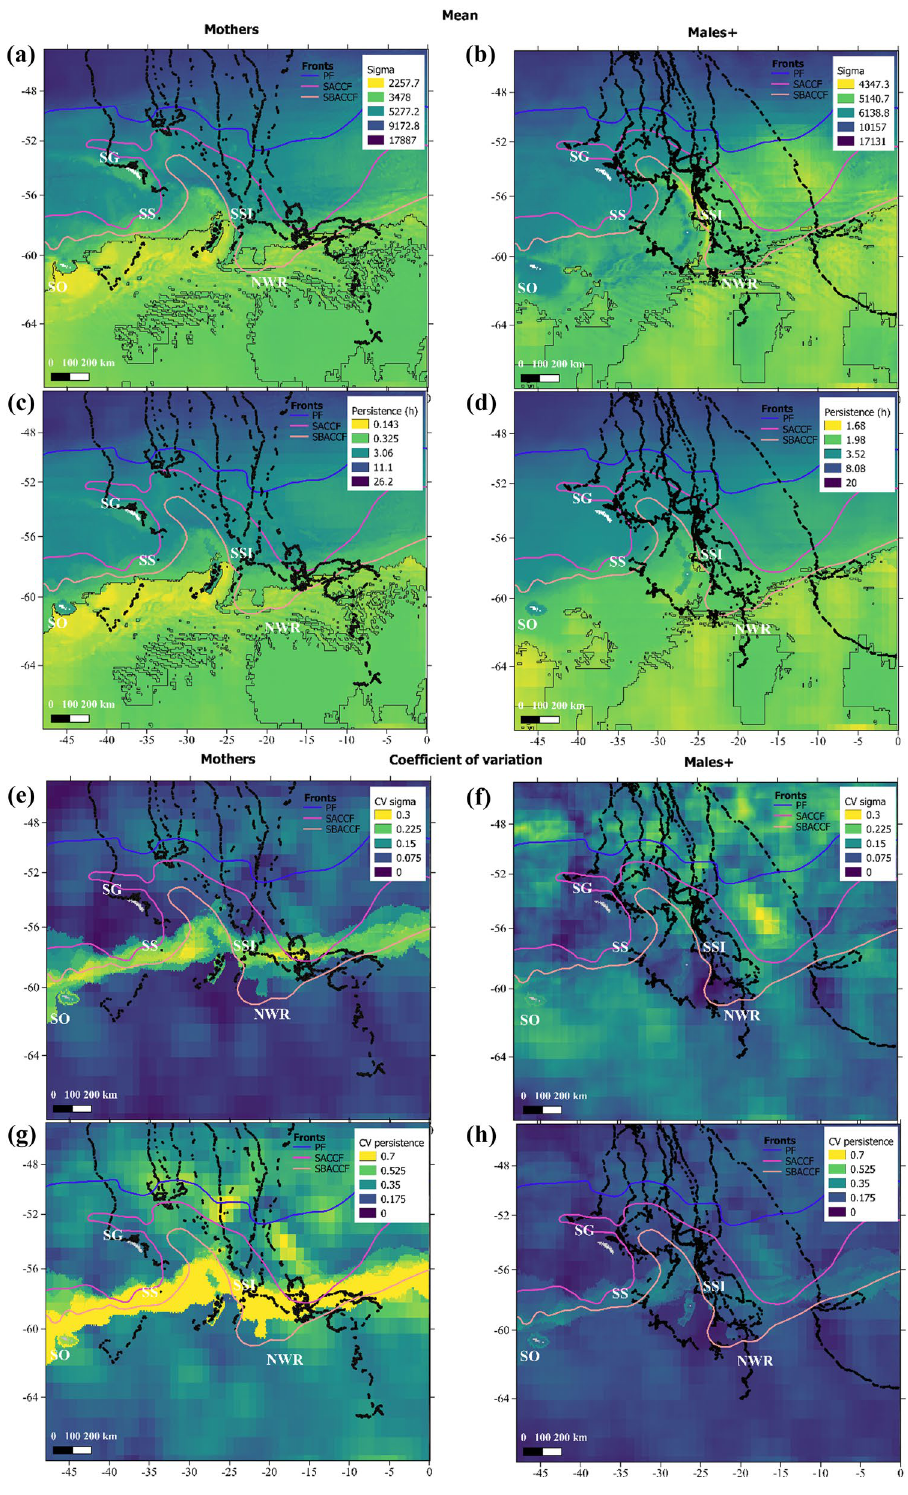
Figure 4. Top panels ( a – d ) show mean expected change in sigma ( σ , a , b ) and persistence ( p t = 3/β , c , d ) based on oceanographic conditions of January from 2010 to 2019, using the best P-model. Colors in spatial predictions are based on 25% percentiles. Black contoured polygons indicate areas where the 25% lowest values of sigma and persistence cooccurred. Bottom panels ( e – h ) show associated coefficient of variation for the means. Left panels ( a , c , e , g ) show results for mothers and right panels show results for males + ( b , c , g , h ). Black dots represent observed locations at the feeding grounds. Colored lines denote the location of polar front (PF), Southern Antarctic Circumpolar Current Front (SACCF), and the southern boundary of the Antarctic circumpolar current (SBACCF). The location of South Georgia (SG), Scotia Sea (SS), South Sandwich Islands (SSI), South Orkney (SO) and Northern Weddell Ridge (NWR) are indicated by respective acronyms. Antarctic